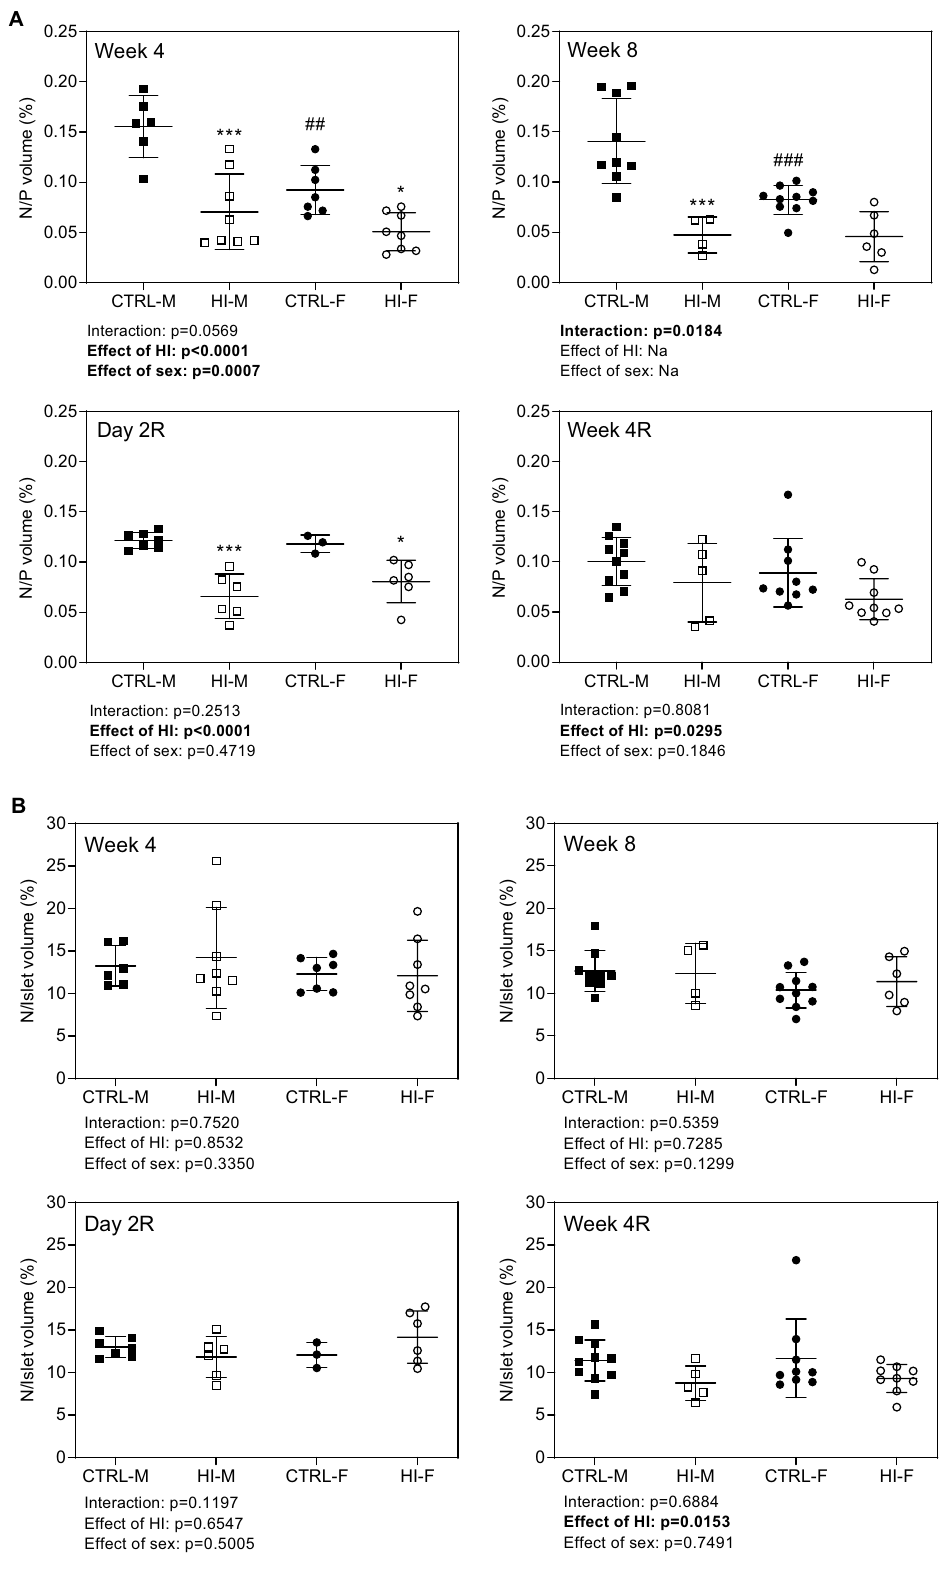
Figure 7. Relative β-cell nucleus to pancreas and islet volume, individual (symbols) and means ± SDs. ( A ) β-cell nucleus to pancreas volume, ( B ) β-cell nucleus to islet volume. Week 4 : CTRL-M, n = 6; HI-M, n = 8; CTRL-F, n = 7; HI-F, n = 8. Week 8 : CTRL-M, n = 9; HI-M, n = 4; CTRL-F, n = 10; HI-F, n = 6. Day 2R : CTRL-M, n = 7; HI-M, n = 6; CTRL-F, n = 3; HI-F, n = 6. Week 4R : CTRL-M, n = 10; HI-M, n = 5; CTRL-F, n = 9; HI-F, n = 9. * p < 0.05, *** p < 0.001 versus control group for the same